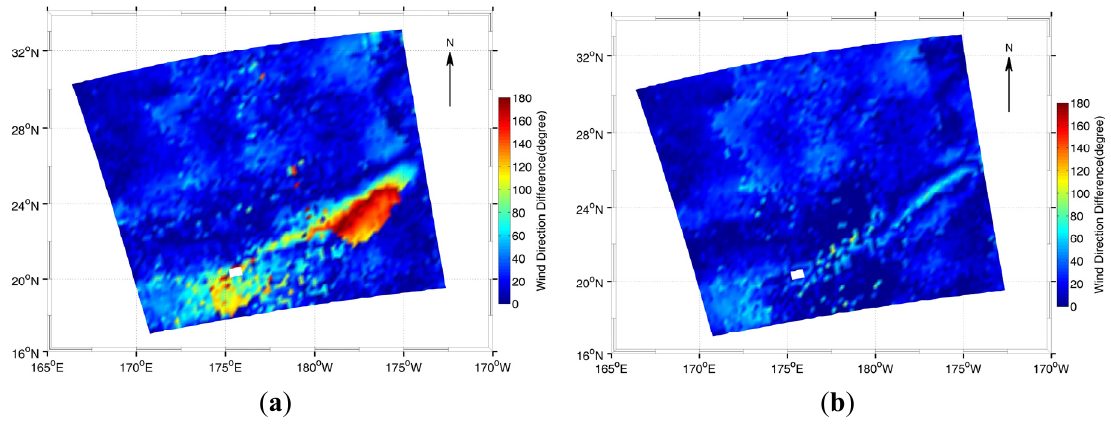
Figure 7. The images of wind direction difference between ( a ) the L2B wind and the NWP wind; ( b ) the integrated algorithm and the NWP wind; and ( c ) the integrated algorithm and the L2B